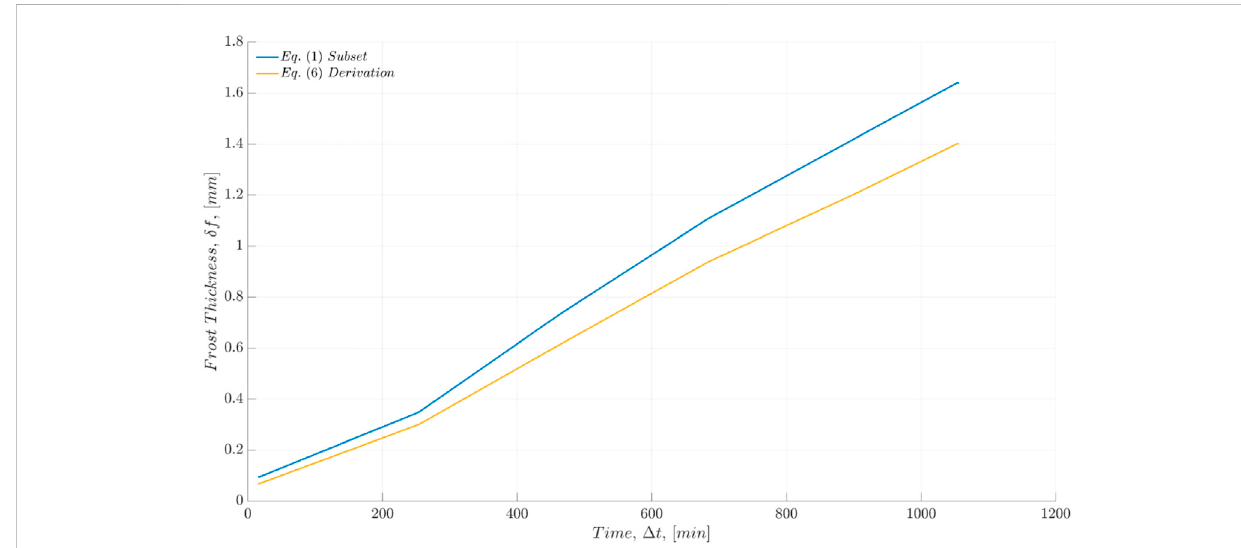
FIGURE 9 Estimation function output comparison; Eqs 1a, 1b, 1c, 1d subset against Eq. 6